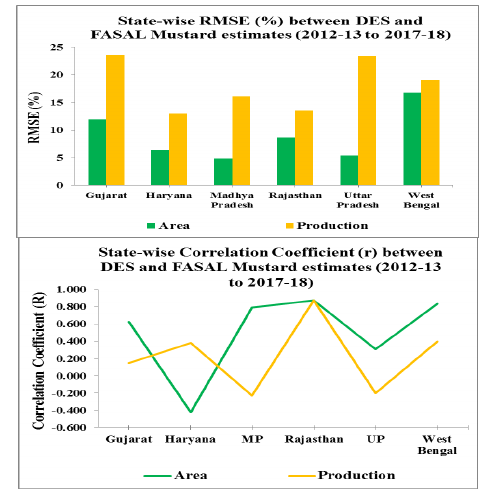
Figure 12: State-level state-wise comparison between DES